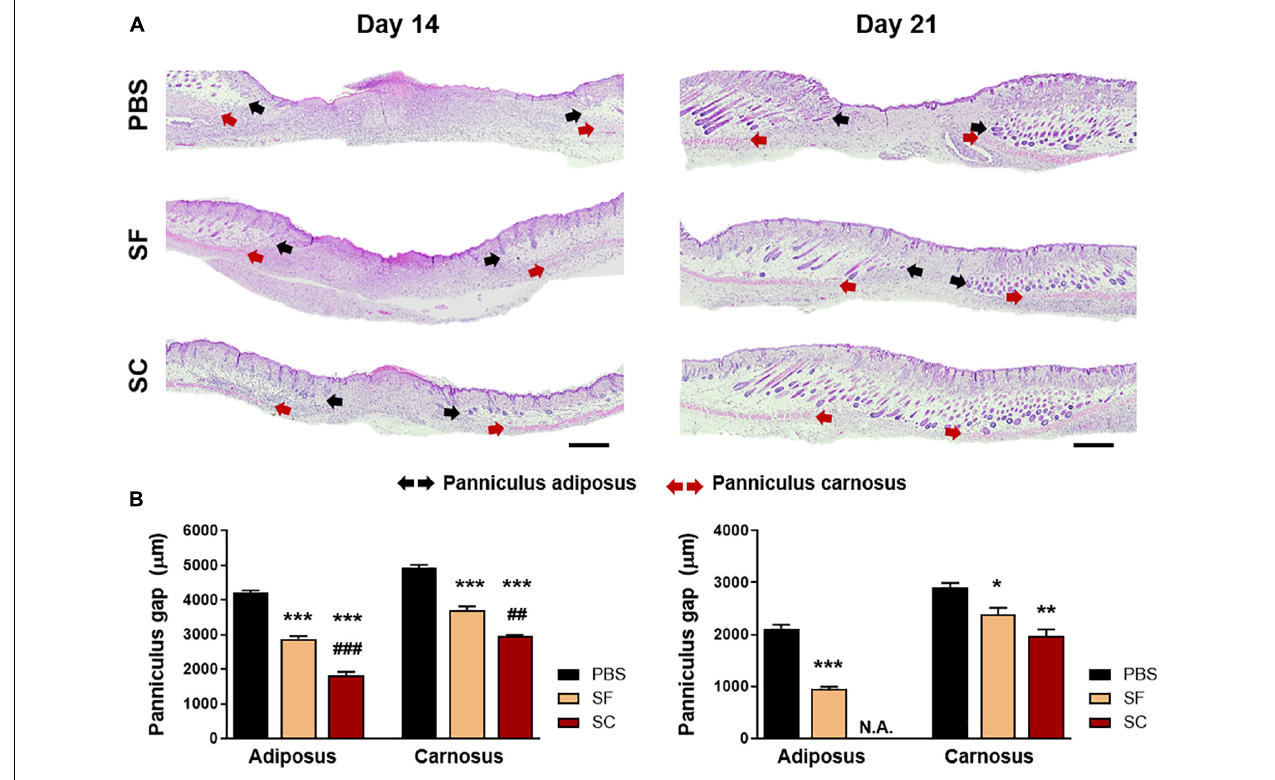
FIGURE 4 | Hematoxylin and eosin (H&E) staining of the wound on days 14 and 21. (A) Light microscopy images of the wound bed representing the panniculus adiposus (black arrow) and carnosus (red arrow) (Scale bar = 500 µ m). (B) Quantitative measurement of the panniculus gap at days 14 and 21 (*compared with the PBS group; # compared with the SF group; * p < 0.05; ** ## p < 0.01; *** ### p < 0.001).